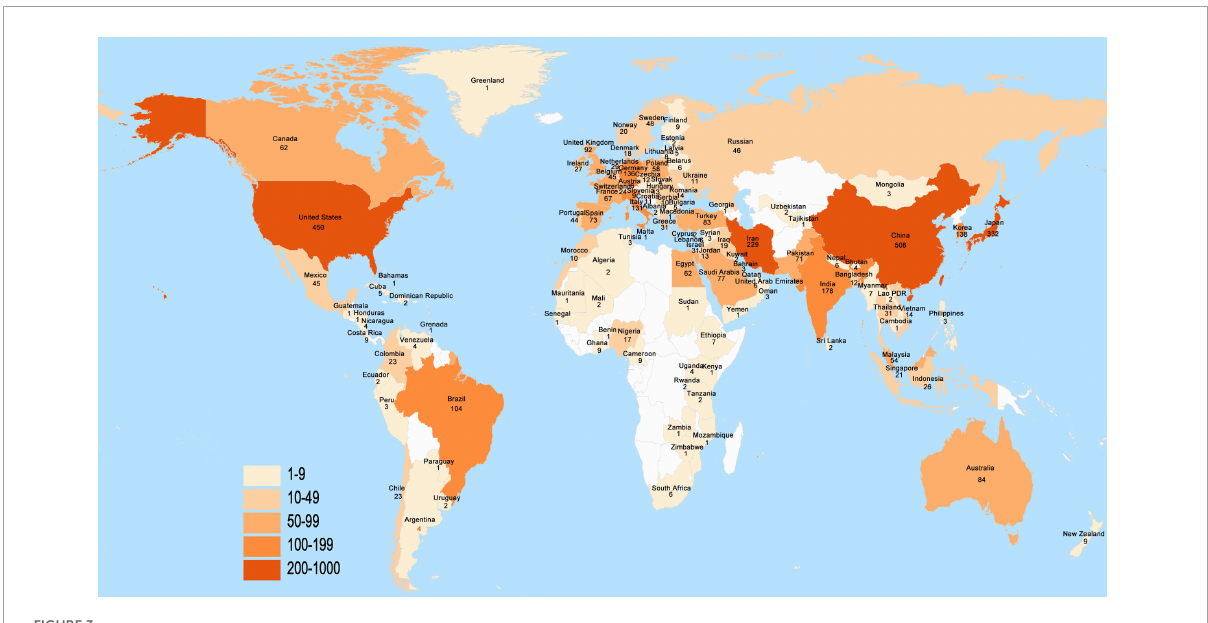
FIGURE3 The distribution of Helicobacter pylori -related gastric ulcer (GU) research worldwide, from 2012 to